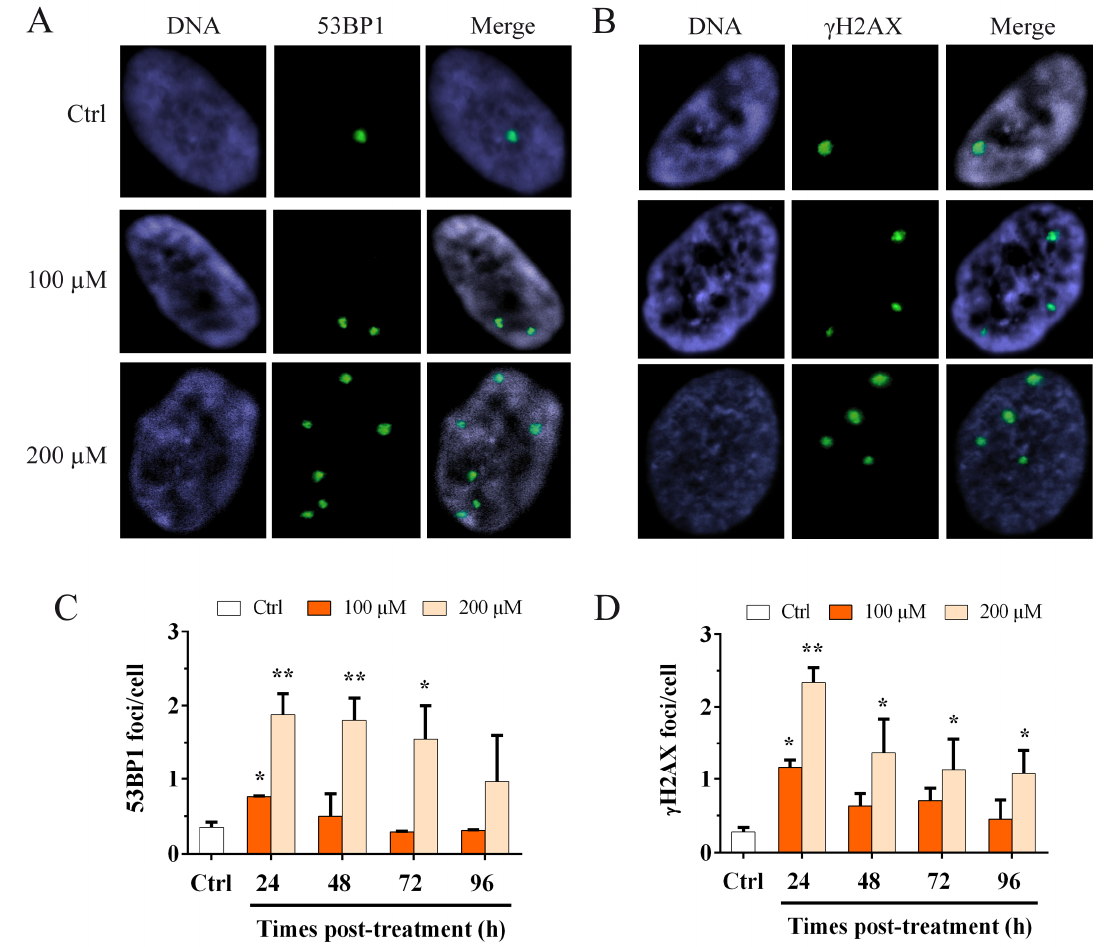
Figure 3. Immunofluorescence staining for 53BP1 and γ H2AX foci. Images of MRC-5 cells stained for ( A ) 53BP1 and ( B ) γ H2AX. Immunofluorescence staining for 53BP1 and γ H2AX was used to detect the activation of the genomic DDR. The columns show the frequency of ( C ) 53BP1 foci per cell and ( D ) γ H2AX foci per cell, evaluated after 100 and 200 µ M H 2 O 2 treatment. At 24 h after treatment, we observed a significant increase in the 53BP1 and γ H2AX foci for both doses. Conversely, for the higher dose, we showed a significant increase in both 53BP1 and γ H2AX at 24 h that significantly persisted for up to 96 h. The bars denote the standard error. Statistical analysis was performed between treated and control samples. * p < 0.05; ** p < 0.01 by Student’s t-test.